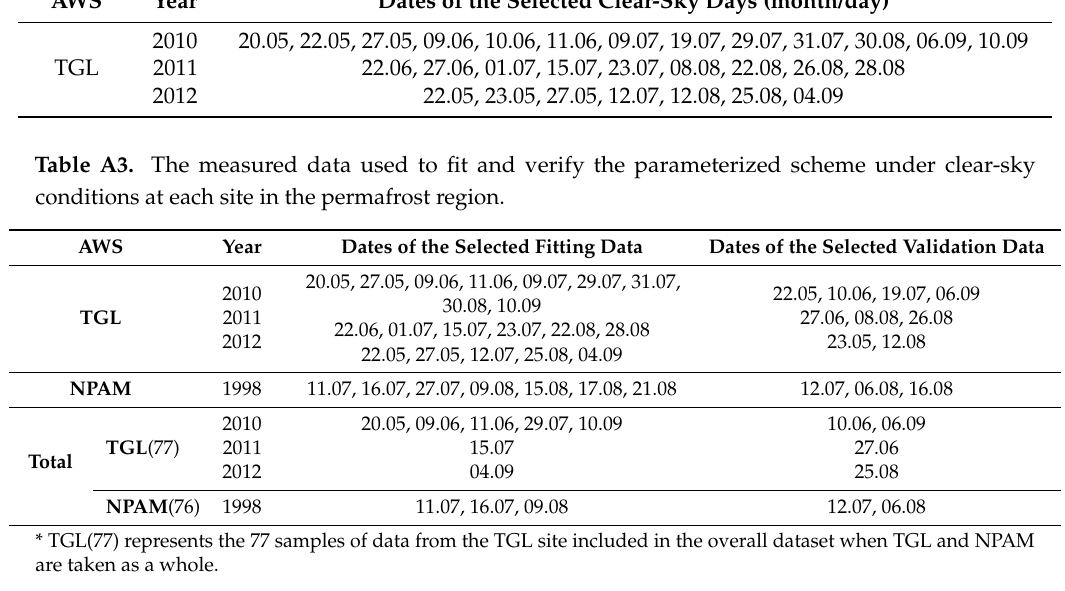
Table A2. Dates of the selected clear-sky days at TGL (20.05–20.09, 2010–2012). AWS Dates of the Selected Clear-Sky Days (month/day)